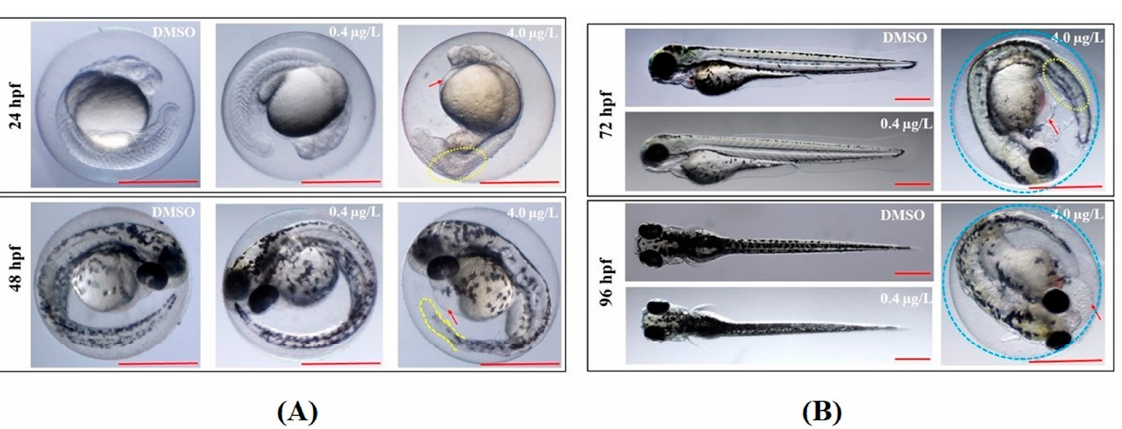
Figure 1. Representative zebrafish images showing malformations induced at specific thiram doses. ( A ) Upper panel (24 hpf) and lower panel (48 hpf); ( B ) upper panel (72 hpf) and lower panel (96 hpf). Yellow dotted ovals, abnormal somites; red arrows, pericardial edema; blue dotted circles, unhatched embryos; yellow dotted line, abnormal tail shape. Scale = 0.5 mm. Table 1. Proportions of developmental deformities scored after 24, 48, 72, 96, and 144 h of thiram exposure.